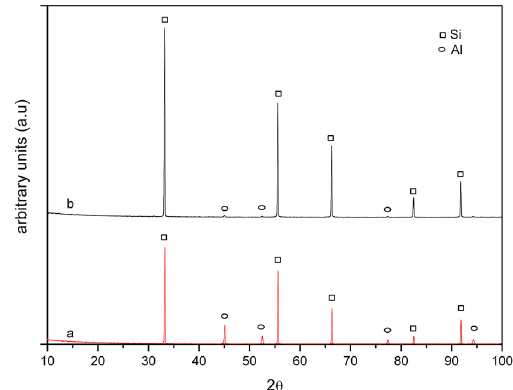
Figure 3. X-rays diffraction profile for samples: a) with antireflection layer and b) without antireflection layer.